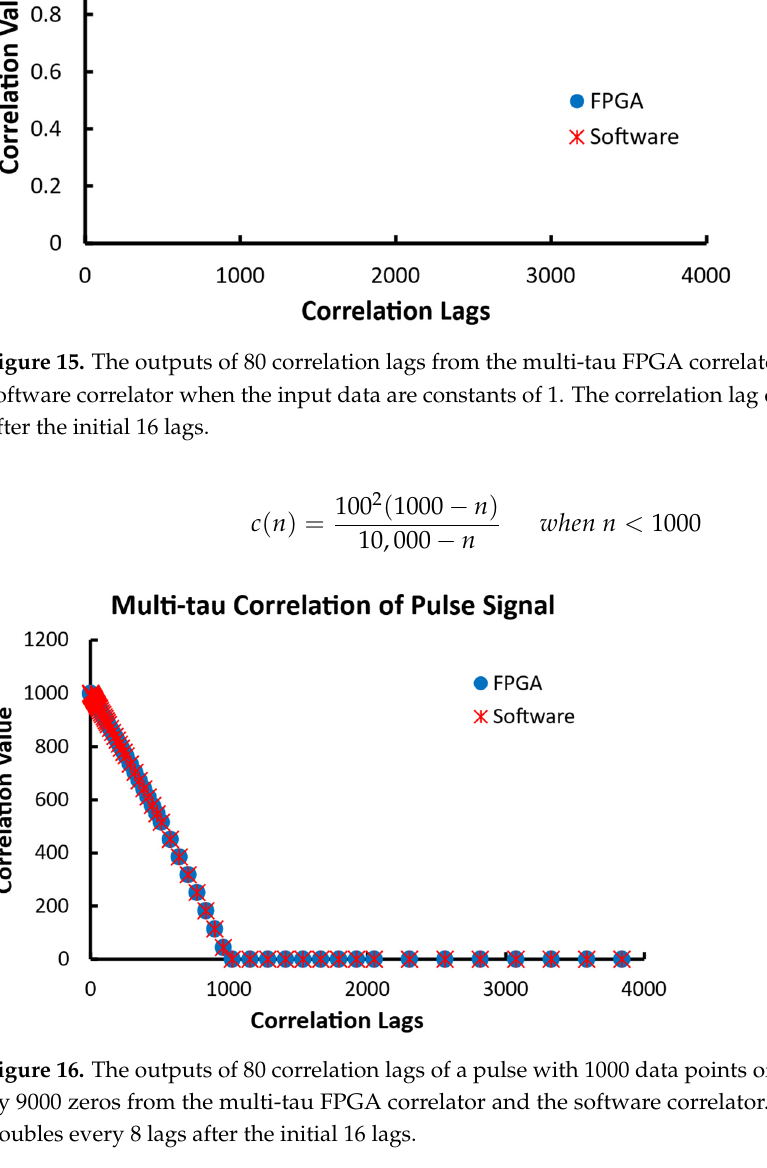
Figure 16. The outputs of 80 correlation lags of a pulse with 1000 data points of value 100 followed by 9000 zeros from the multi-tau FPGA correlator and the software correlator. The correlation lag matched doubles every 8 lags after the initial 16 lags.